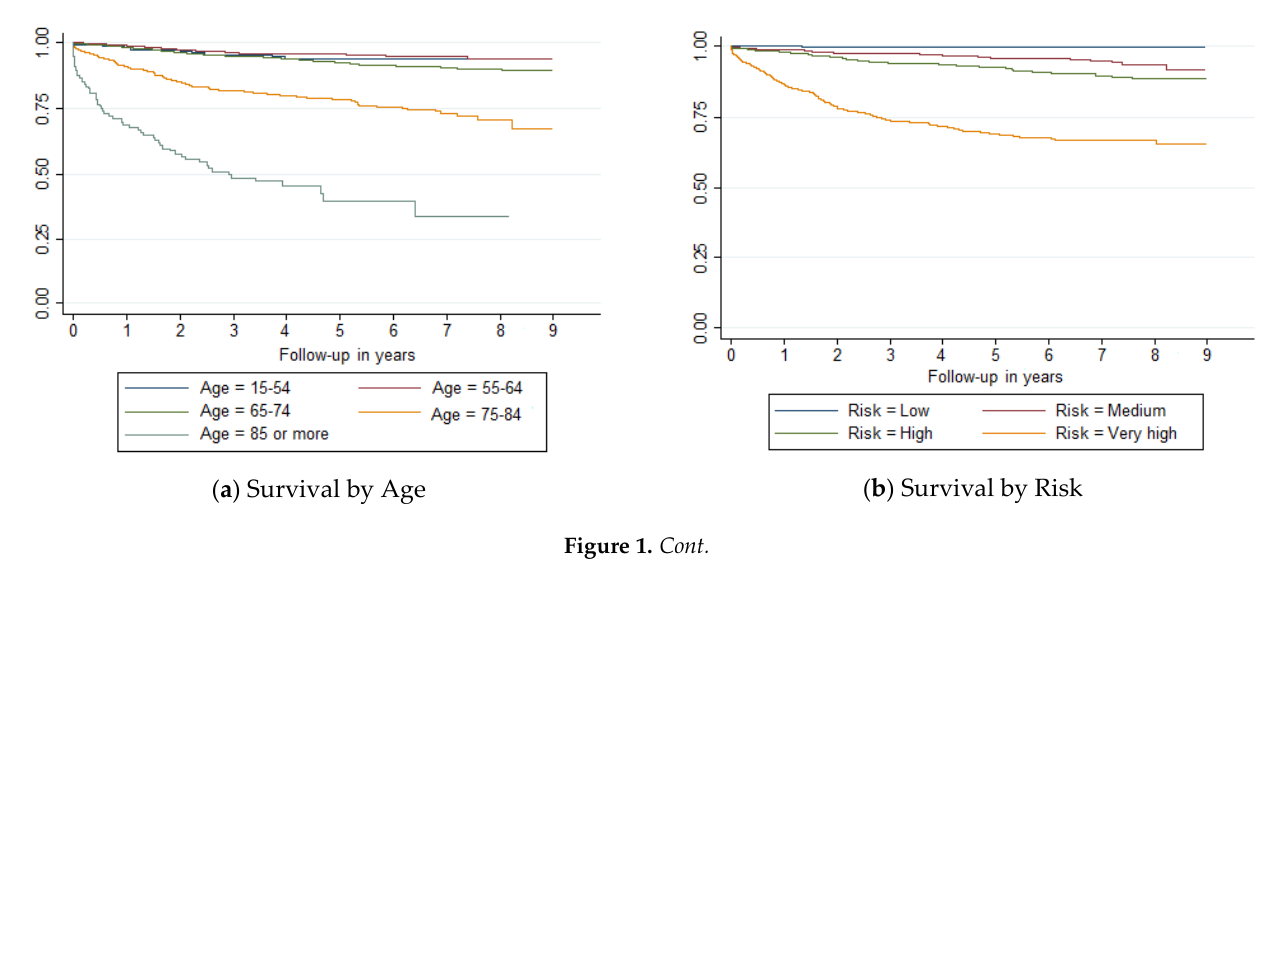
Table 4. Five year relative survival by risk before and after multiple